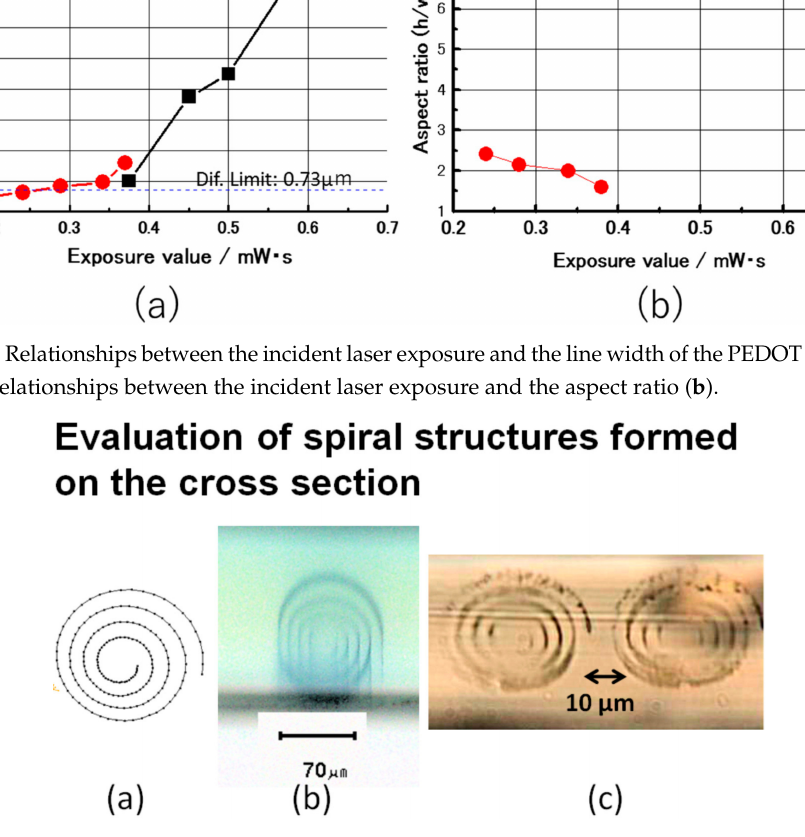
Figure 5. Design of flat spiral pattern ( a ), cross-sectional optical micrograph of the PEDOT pattern photofabricated from the laser focus scanning with the dry objective ( b ), cross-sectional optical micrograph of the PEDOT pattern photofabricated from the laser focus scanning with the oil immersion objective ( c